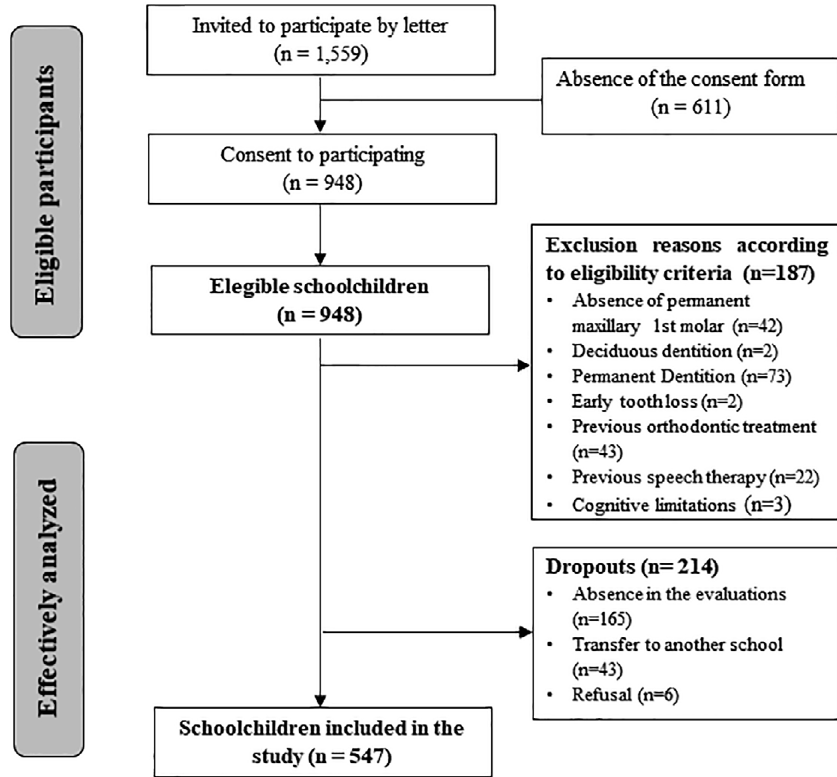
Figure 1- Flowchart - inclusion and exclusion criteria and sample